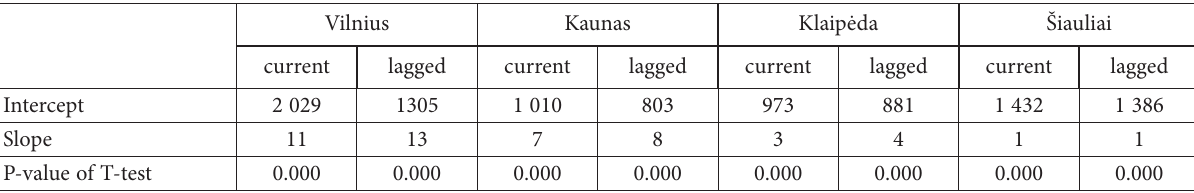
Table 8. Coefficients of a simple linear regression between the number of newcomers and unemployment rate